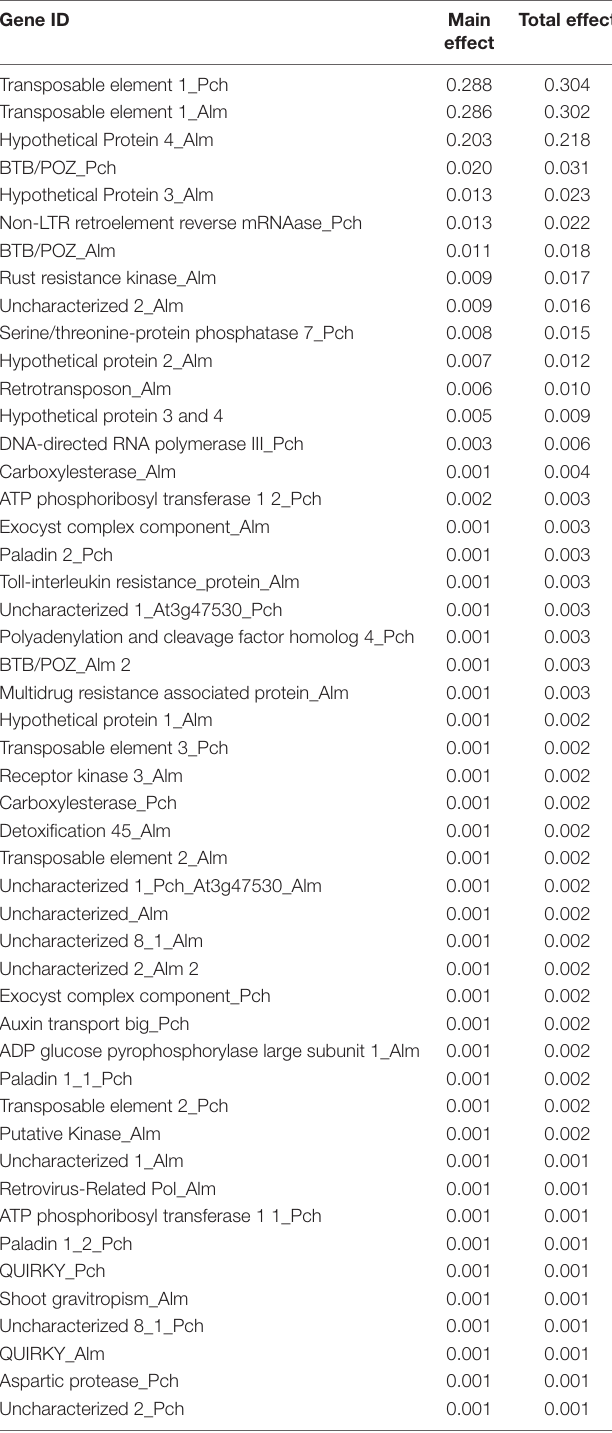
TABLE 4 | Ranking of indices estimated in the assessment of variable importance for normalized Cq values of 48 gene targets considered in this study (RPII is not considered since it was used as a